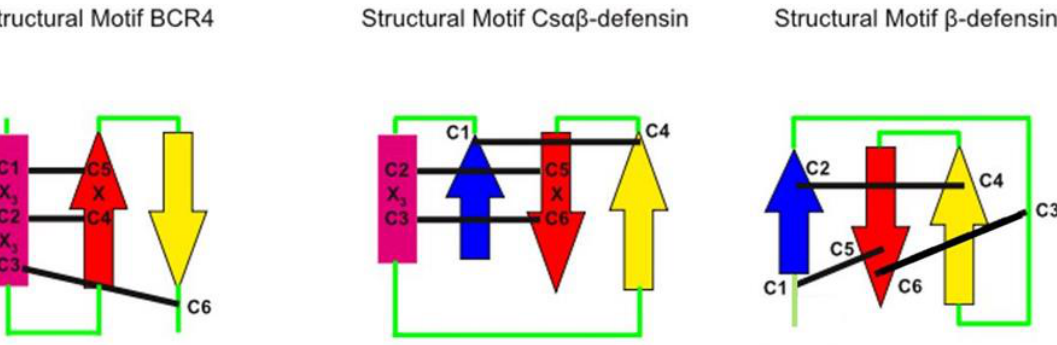
Figure 7. Disulfide connectivities in BCR4 peptide and in CS αβ and β -defensin groups. α -helices are indicated by rectangle, β -strands are represented by arrows, and disulfides in black lines.